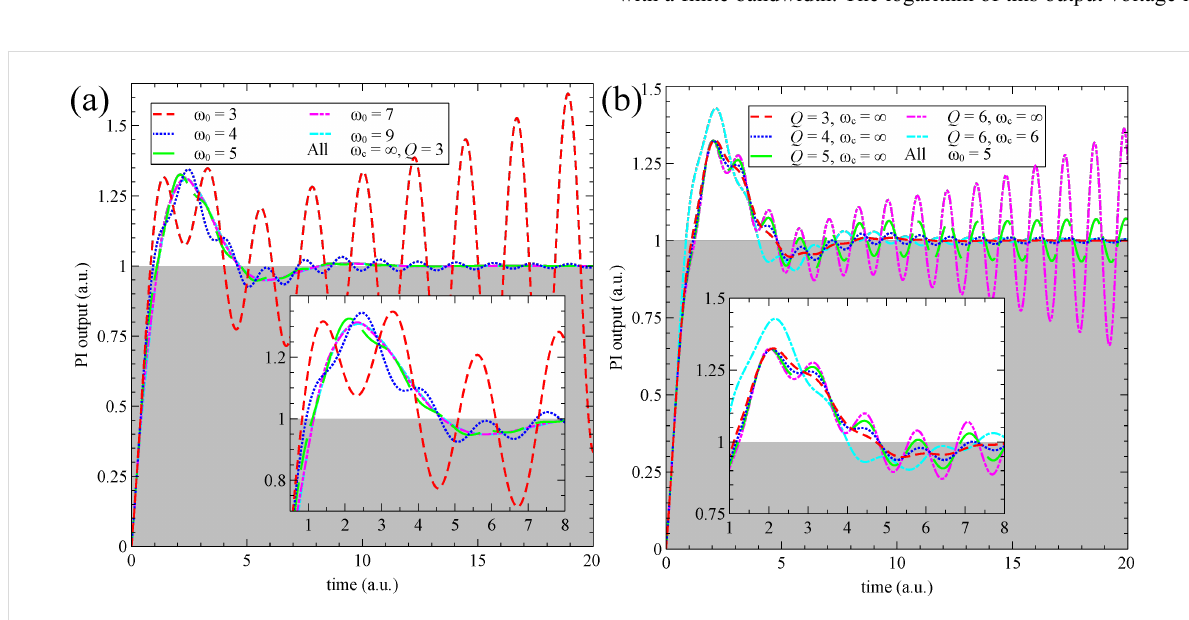
Figure 5: The feedback response of an SPM, including mechanical resonance. (a) Shows the evolution of the feedback output for varying eigenfre- quency of the mechanical resonance. The stability improves for increasing resonant frequency. For all plots the bandwidth of the HV amplifier is infi- nite and the Q of the resonance does not vary. (b) Shows similar evolution in feedback output for varying Q of the resonance at a constant eigenfunc- tion, with lower Q values stabilising the output. The cyan line shows the same resonance properties as the pink line, however by limiting the band- width of the HV amplifier to near that of the resonance, the stability is improved significantly. Both insets are zooms of the most important region of their respective